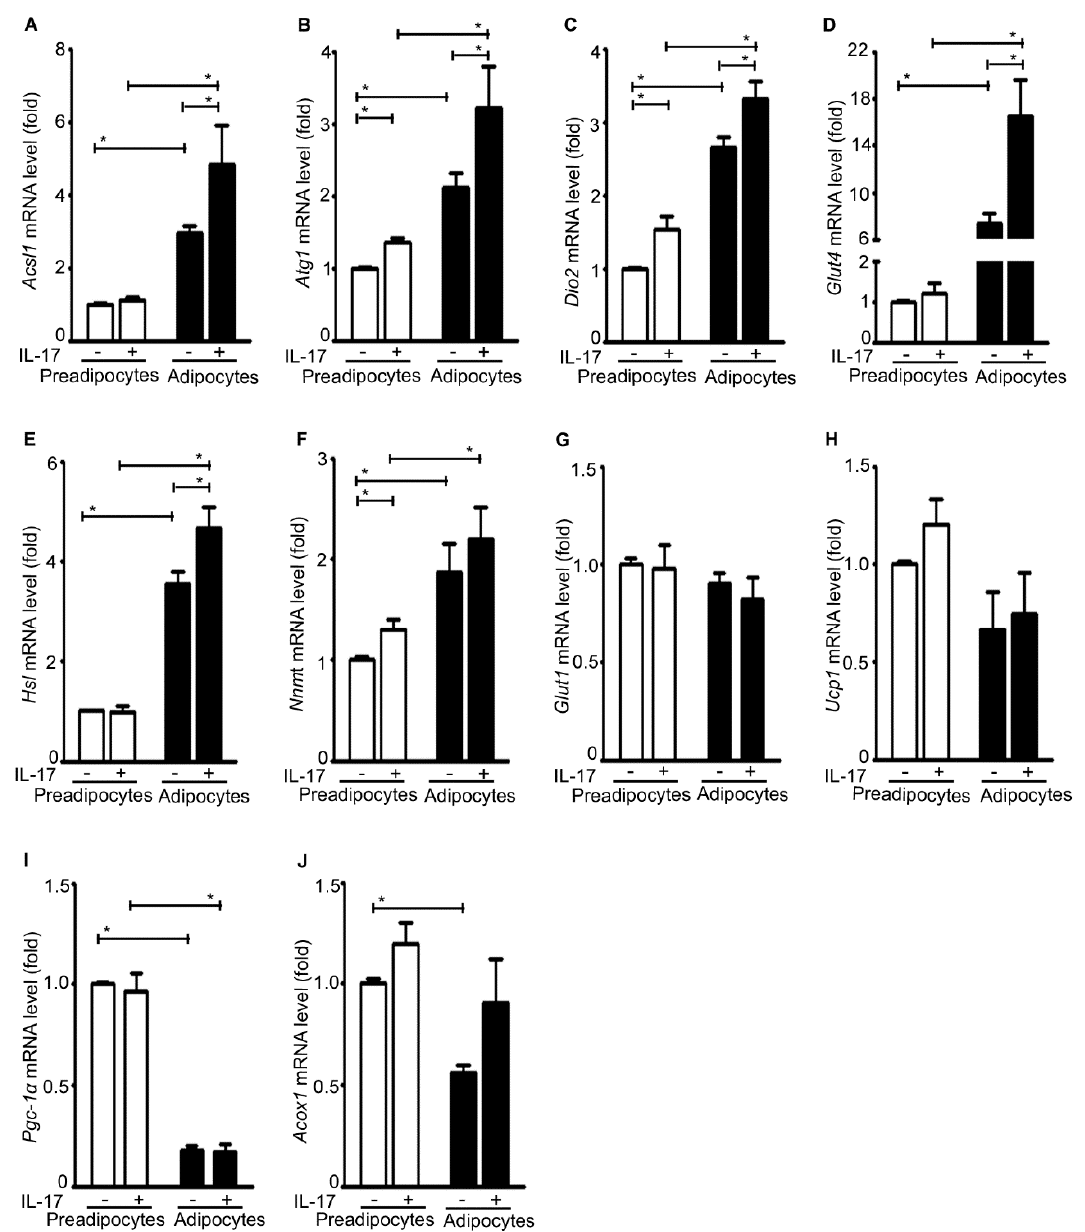
Figure 7. IL-17A differentially induces metabolic gene expression in pre-adipocytes and adipocytes. ( A – J ) The pre-adipocytes and adipocytes were treated without ( − ) or with (+) 20 ng/mL IL-17A for 2 h; mRNA expression of each gene was analyzed with qRT-PCR; the pre-adipocytes without IL-17A treatment served as the basal level for comparison; data represent mean ± SEM (error bars) of six independent experiments ( n = 6 per group), * p < 0.05 between the indicated groups.